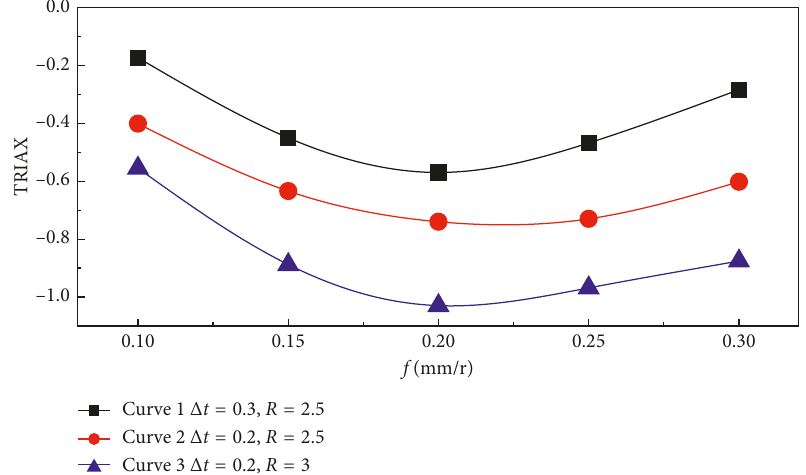
Figure 9: Graph of change in AVRST with feed